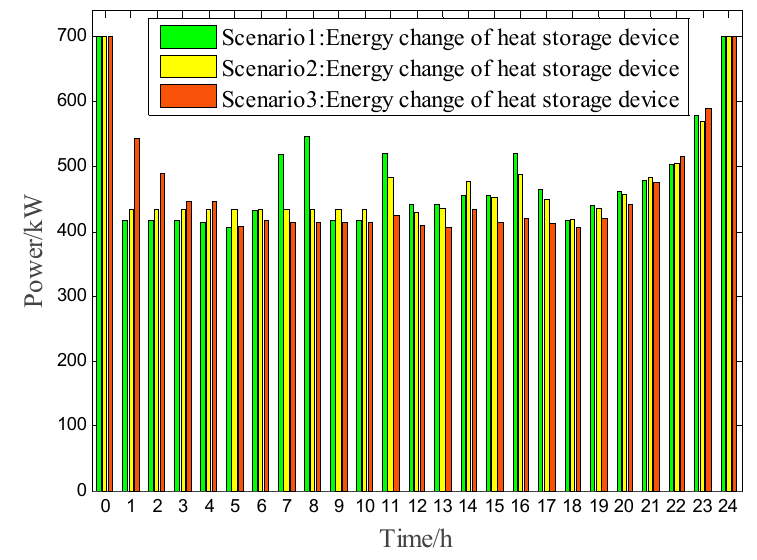
Figure 12. Energy storage changes of heat storage device in different scenarios.